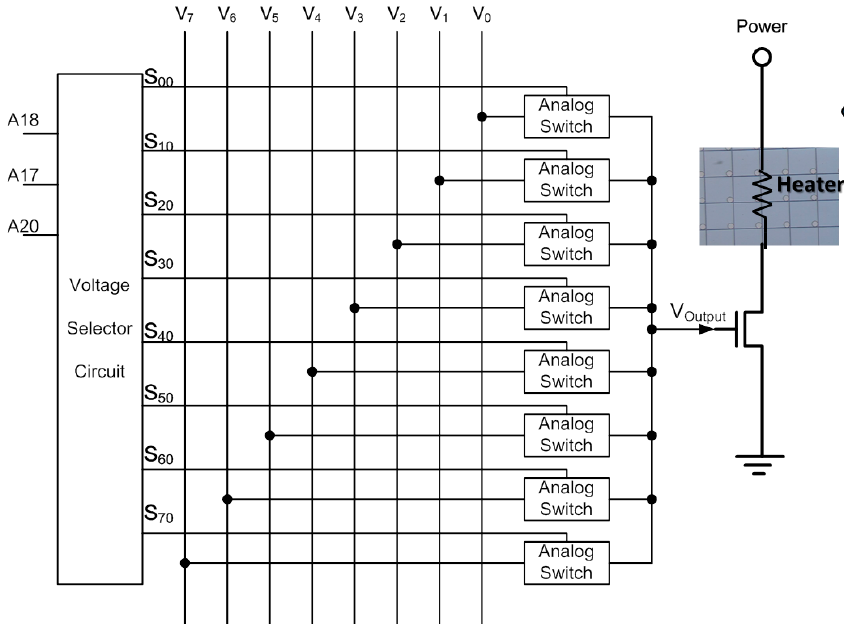
Figure 5. Power grayscale output cell.